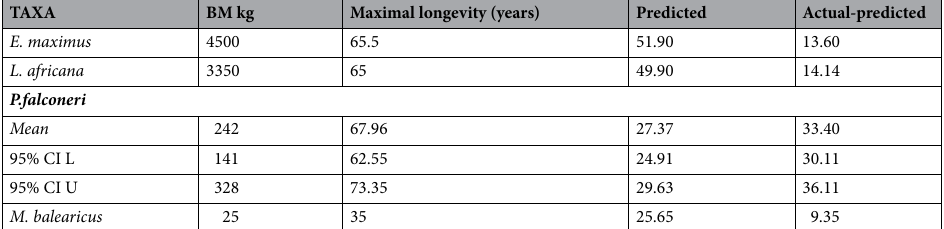
TAXA BM kg Maximal longevity (years) Predicted